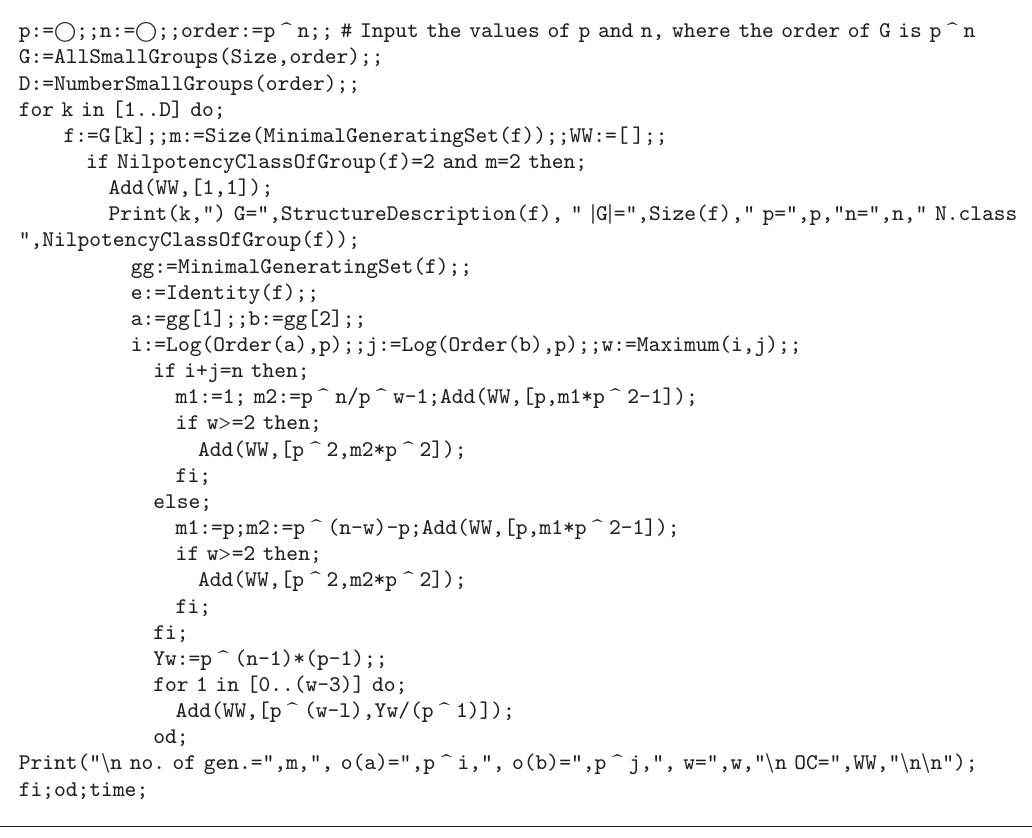
Algorithm 1: Theorem 7 in GAP’s algorithm.